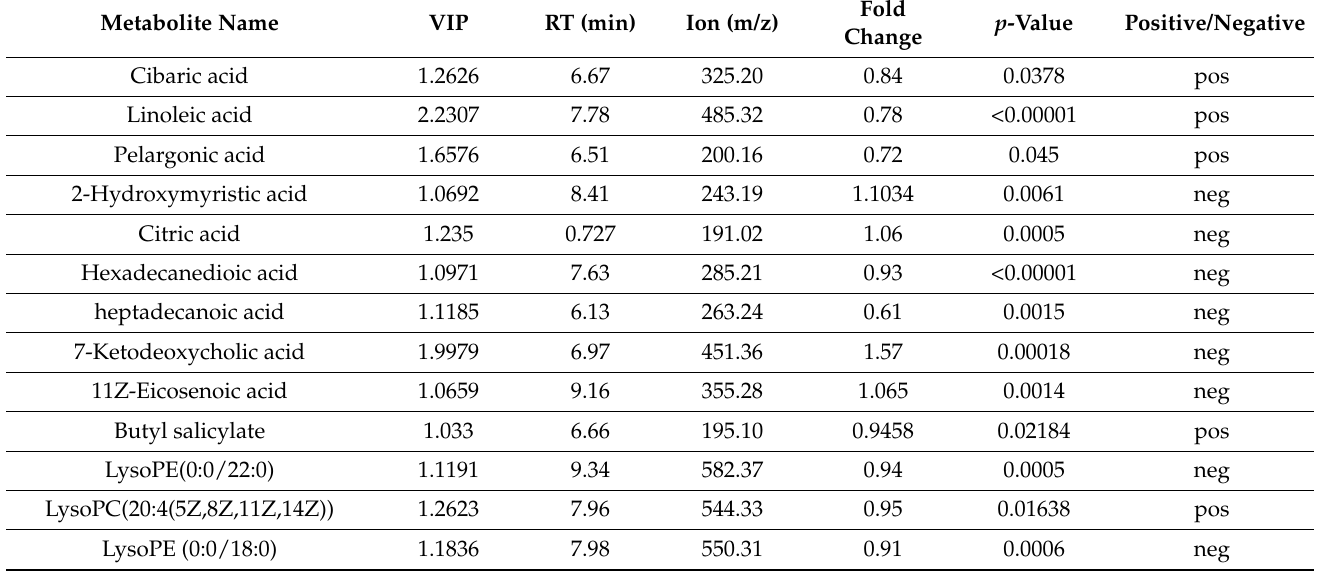
Table 3. Identification of different serum metabolites in cows fed the HE diet compared to cows in the control